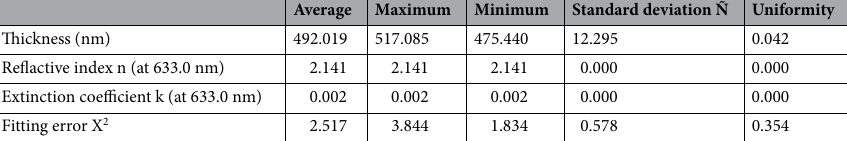
Average Maximum Minimum Standard deviation Ñ